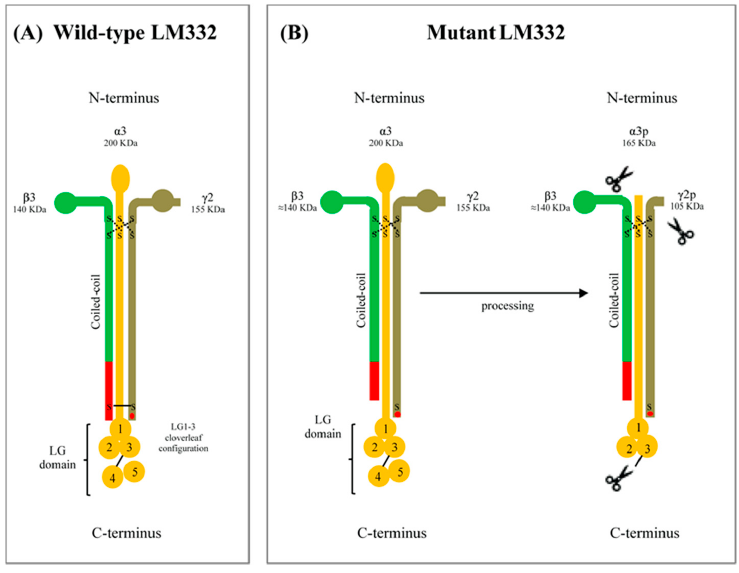
Figure 4. Schematic of the laminin-332 (LM332) structure and its maturation process. ( A ) Unprocessed, intracellular form of the wild-type LM332. It consists of three chains: α 3 (200 kDa), β 3 (140 kDa)